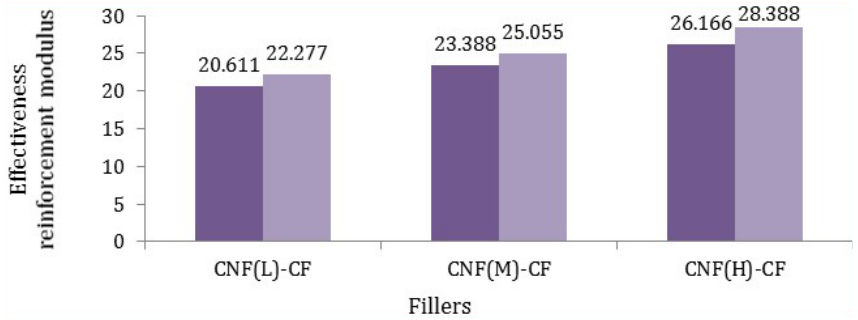
Figure 8. Effective reinforcement modulus of different fillers in polypropylene matrix (dark purple states minimum amount and light purple reveals maximum amount).